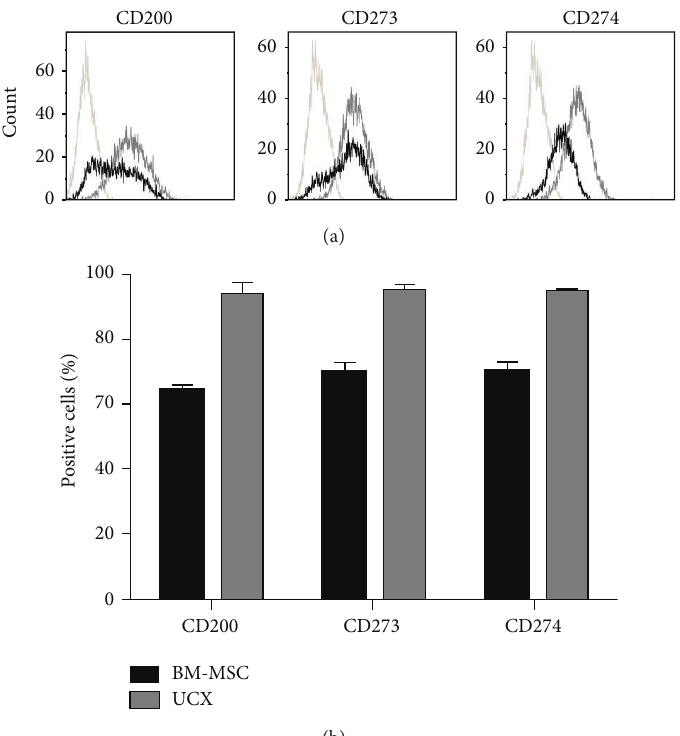
Figure 6: Flow cytometry surface expression studies of CD200, CD273, and CD274 in UCX and BM-MSCs. (a) Representative histograms of staining for the three surface proteins in UCX (grey lines) and BM-MSCs (black lines) and respective isotype controls. (b) Graphical representation of the percentage of cells positive for each surface protein from 3 different samples of each cell type (between passages 5 and 7) and presented as mean ± s.e.m. A higher percentage of UCX cells constitutively express CD200, CD73, and CD274 when compared to